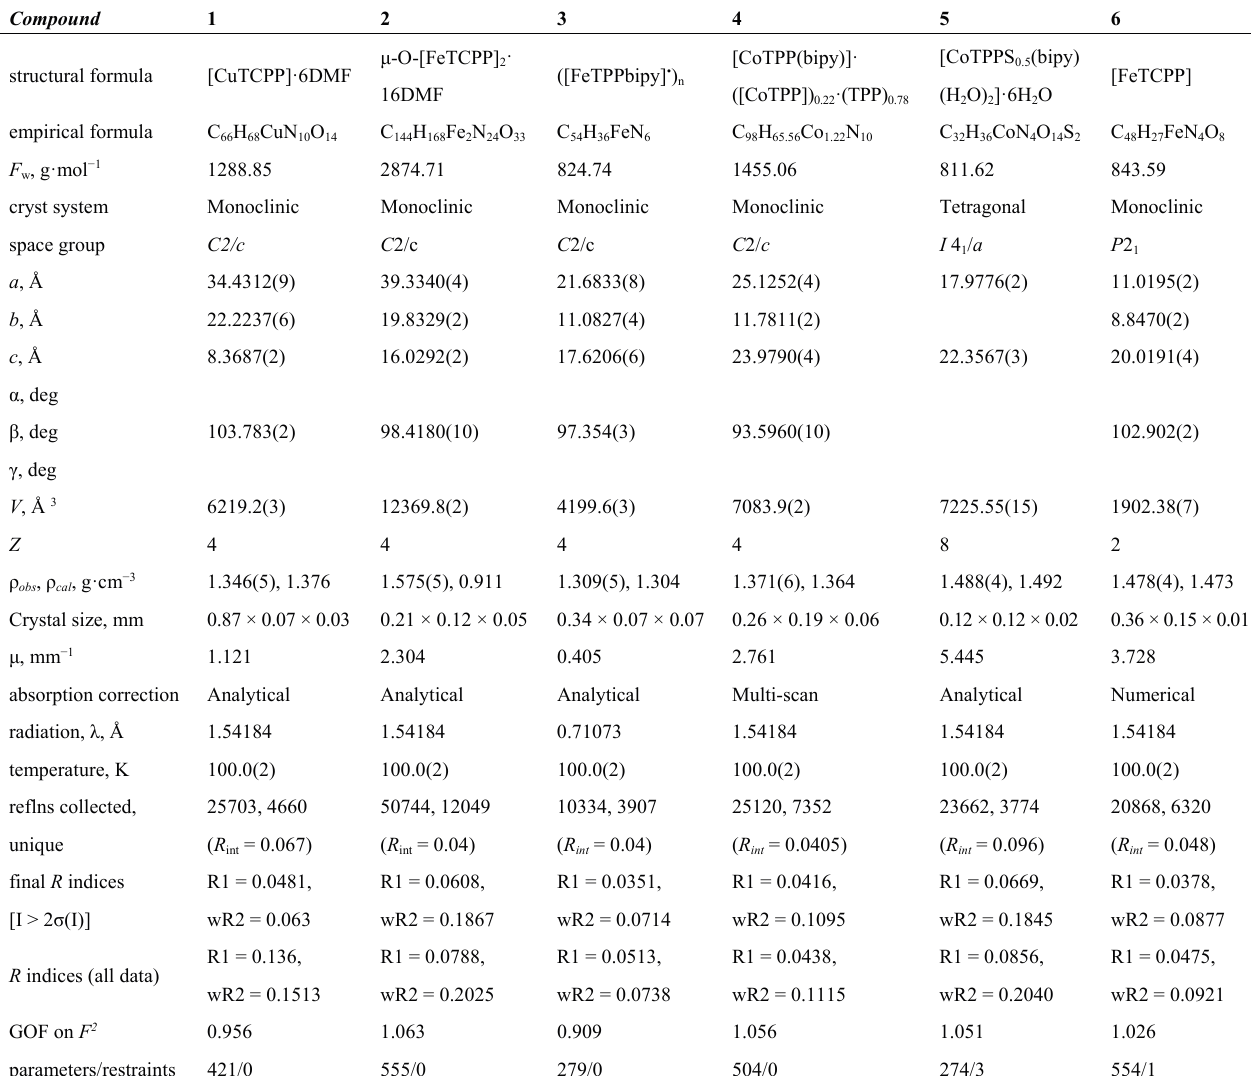
Table 1. Crystal data and structure refinement for compounds 1 – 6